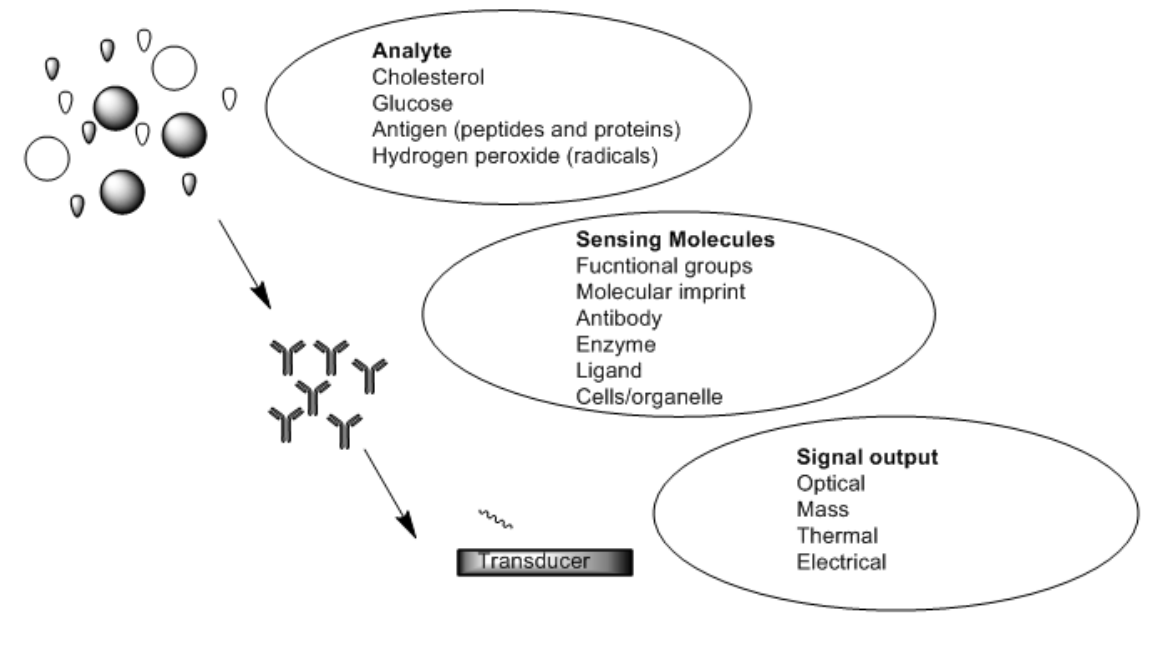
Figure 2. Schematic depicting functional principles of a